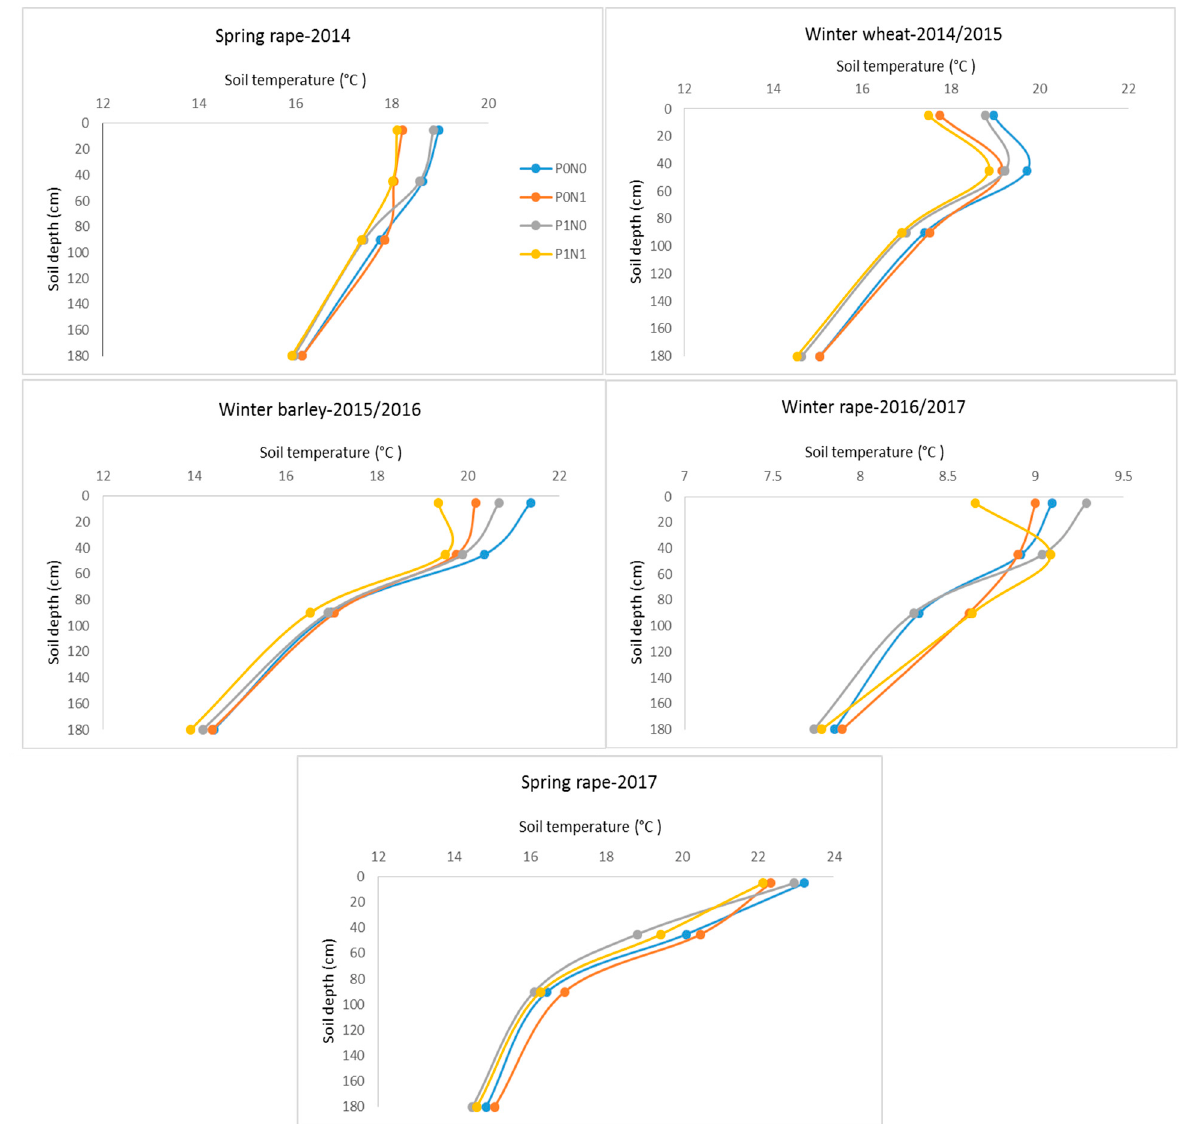
Figure 5. Soil temperature ( ◦ C) at different soil depths according to the fertilizer rate and tillage system at the late plant growth stage.